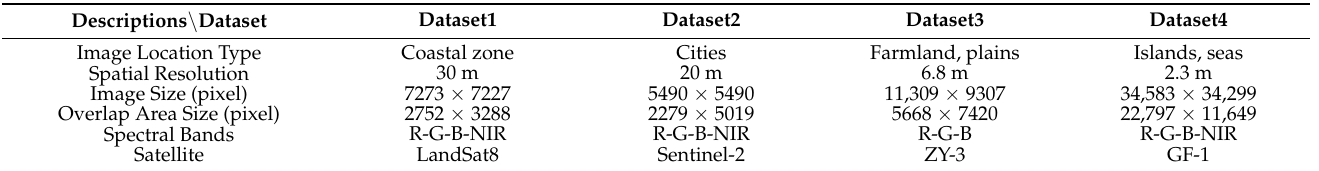
Table 1. Description of the data used in the